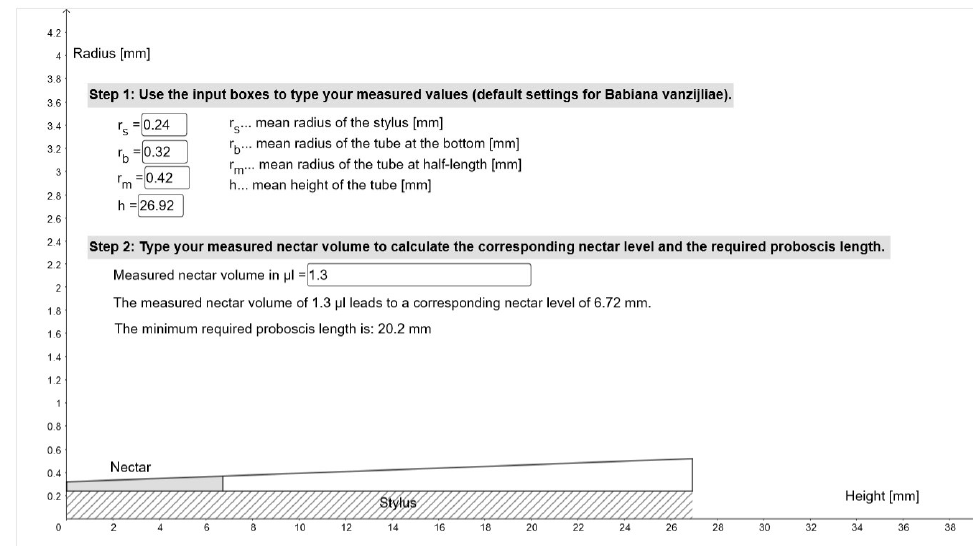
Figure A2. Calculation of nectar height inside a tubular flower (screen shot of GeoGebra); step 1: type in the measured dimensions of the tubular flower; step 2: type in the measured nectar volume (e.g., from micropipette measurements). The tool automatically calculates and illustrates the corresponding nectar level. The tool also provides information on the required proboscis length to reach the nectar. https://www.geogebra.org/m/se2cwx9s, accessed on 16 April 2021.